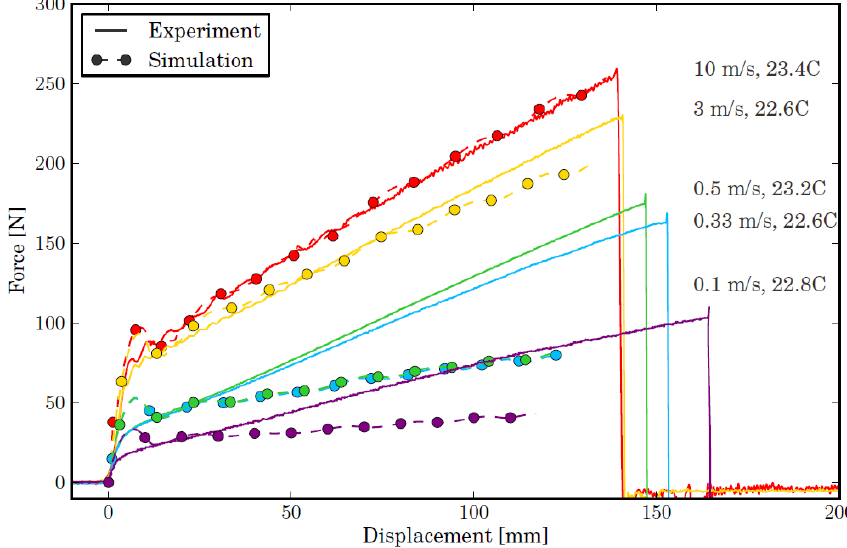
Fig. 14 Force vs. displacement for uniaxial tensile tests; simulated results for material model calibrated at 10 m/s and 23.2